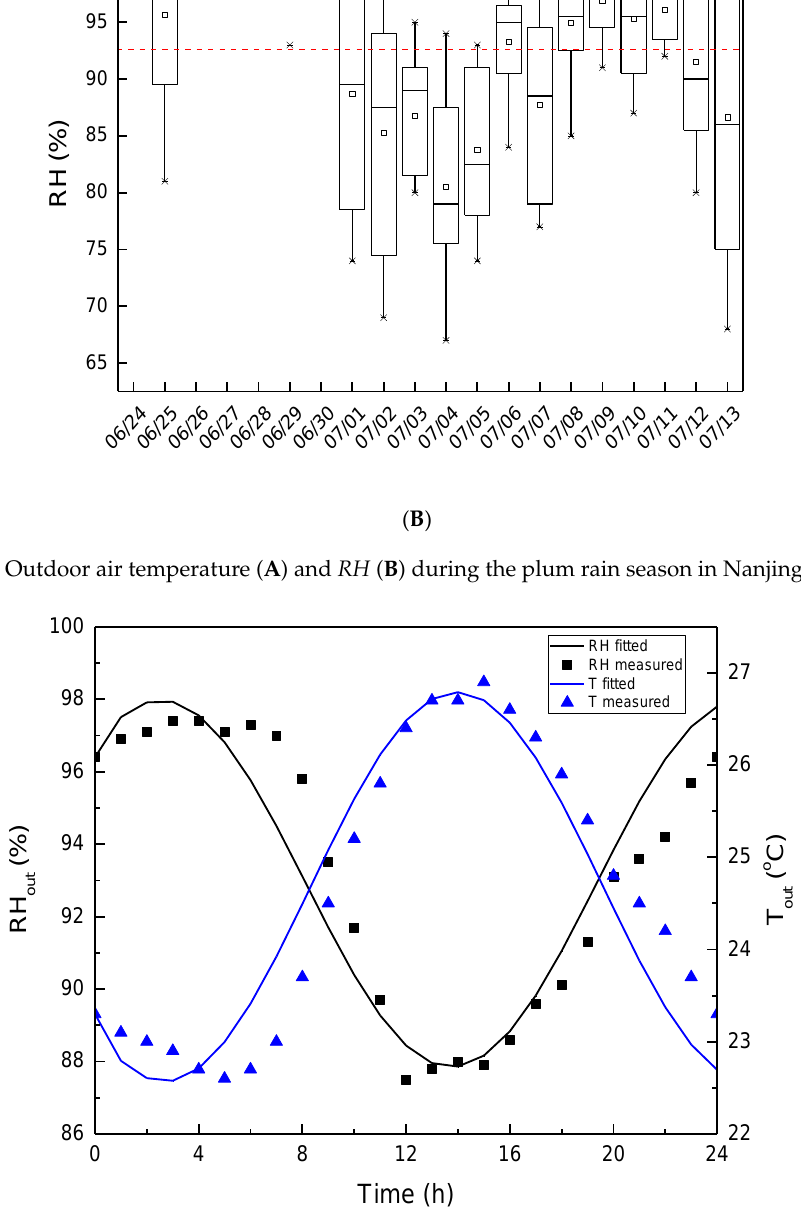
Figure 4. The diurnal variation of outdoor air temperature and RH on a plum rain day.